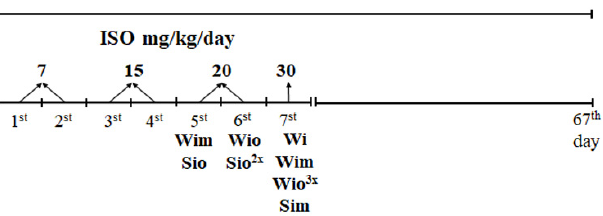
Figure 1. Design of the experiment and mortality rate: ISO was applied during 7 days in dose 7, 15, 20, 30 mg/kg (s.c.) to S and W rats. Drinking of melatonin and feeding with omega-3 was realized from the 1st until the 67th day. The highest mortality was registered after the last injection of ISO on day 7. W-Wistar rats; Wi-isoproterenol injured W; Wim-melatonin treated Wi; Wio-omacor treated Wi; S-spontaneously hypertensive rats; Si-isoproterenol injured S; Sim-melatonin treated Si; Sio-omacor treated Si.